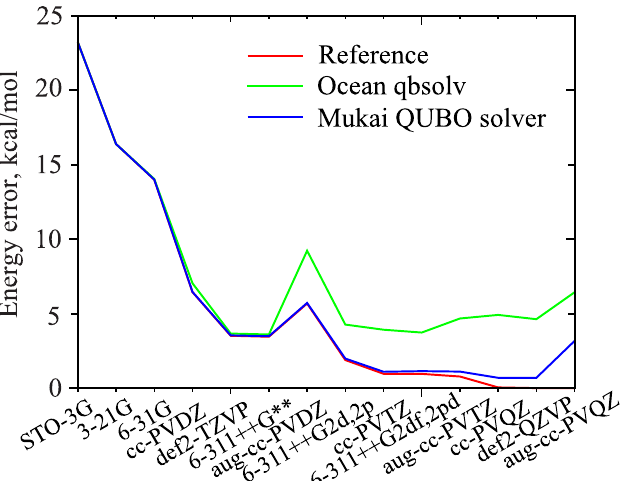
Fig 1. Convergence of the H 2 ground state energy with basis set expansion. The calculations are ordered with increasing Hamiltonian matrix size. The matrices were diagonalized directly (red) and using the QAE + Ocean qbsolv (green) or QAE + Mukai QUBO solver (blue) approaches. The error is given relative to the energy of def2-QZVP reference diagonalization, which has the lowest value among all calculations. The Mukai QUBO solver outperforms the Ocean qbsolv throughout all basis sets by a significant margin.